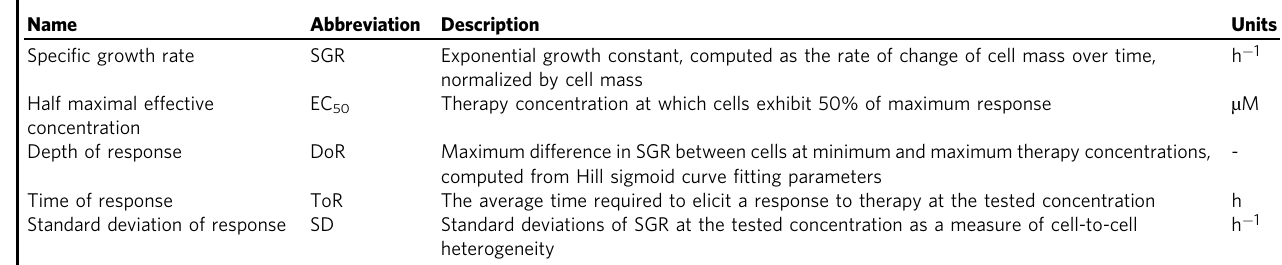
Table 1 Summary of QPI drug response